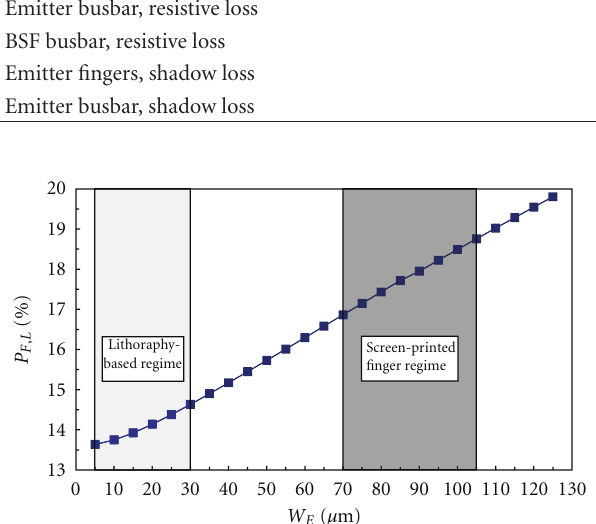
Figure 5: Total fractional (simulated) power loss for an optimized interdigitated thin-film solar cell on glass, as a function of emitter finger width. A cell area of 4cm 2 , maximum power point current density of 25mA/cm 2 , an open-circuit voltage of 400 mV, and an emitter layer sheet resistivity of 400 Ω / (cid:2) have been assumed for this example. Shaded overlays of the approximate emitter widths possible with lithography ( ∼ 5 μ m–30 μ m) and a screen-printed ( ∼ 70 μ m–110 μ m) regime are also included.